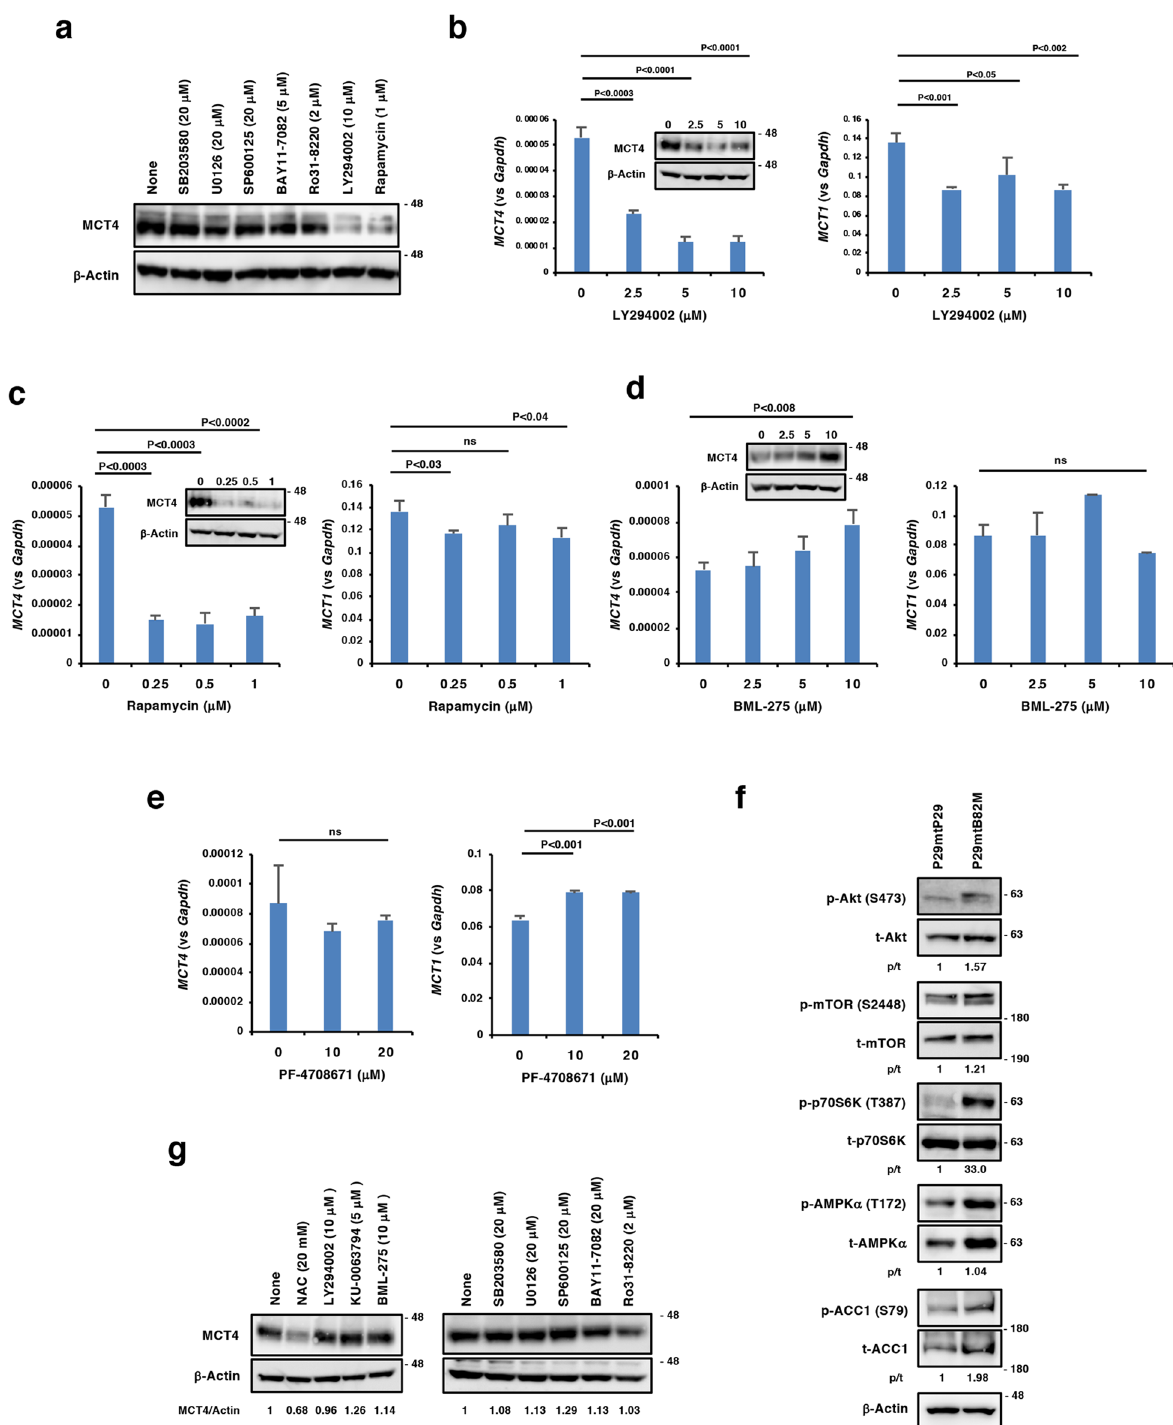
Figure 7. Analyses of signalling pathways involved in MCT4 expression in P29mtB82M and H358 cells by signalling pathway inhibitors. ( a ) Effects of various inhibitors on MCT4 expression in P29mtB82M cells. The cells were treated with the inhibitors at the indicated concentrations for 2 days. ( b – e ) Effect of LY294002, rapamycin, BML-275 and PF-4709671 on the expressions of MCT4 and MCT1. P29mtB82M cells were treated with LY294002 ( b ), rapamycin ( c ), BML-275 ( d ) or PF-4709671 ( e ) at the indicated concentrations for 2 days. The results of RT-qPCR and Western blotting are shown. ( f ) Comparison of phosphorylation levels of various signalling elements in P29mtP29 and P29mtB82M cells. Ratios of phosphorylated/total protein (p/t) are shown. ( g ) Effects of various inhibitors on MCT4 expression in H358 cells. Cells were treated with the inhibitors at the indicated concentrations for 2 days. For Western blotting, β-Actin was used as a loading control. Ratios of MCT4/β-actin are shown. Uncropped Western blot images are provided as Supplementary Fig.